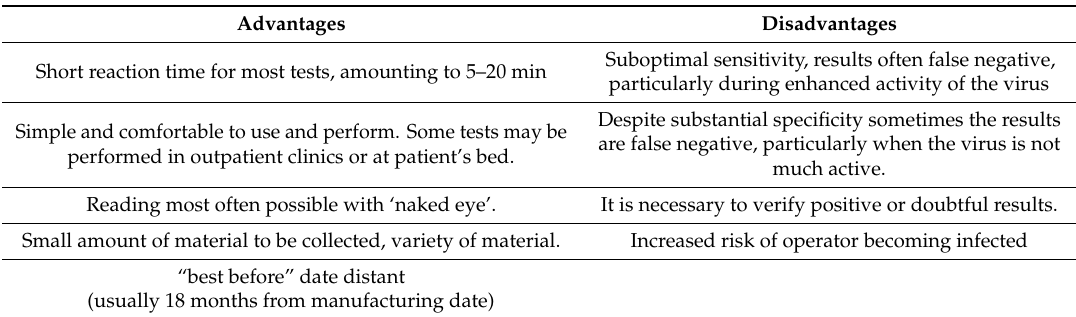
Table 4. The brief comparison of advantages and disadvantages of immunochromatographic